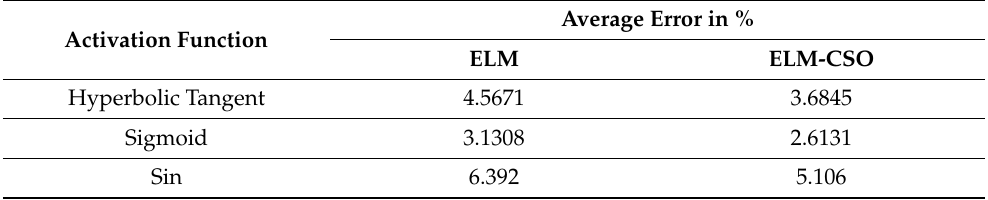
Figure 5. Prediction errors (%) of test data (20%) using ELM with ( a ) hyperbolic tangent, ( b ) sigmoid, ( c ) sinusoidal activation functions, CSO-ELM with ( d ) hyperbolic tangent, ( e ) sigmoid, ( f ) sinusoidal activation functions. Table 3. Average errors of ELM and ELM-CSO methods using different activation functions.